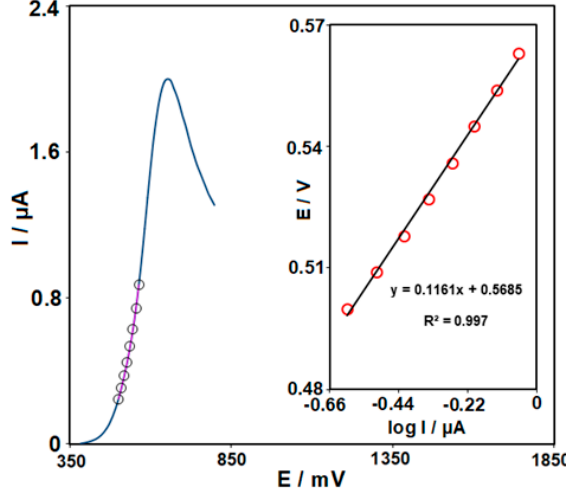
Figure 7. LSV (at 5 mV s − 1 ) of the electrode in 0.1 M PBS (pH = 7.0) containing 50.0 µ M KTC. The points are the data used in the Tafel plot (inset).